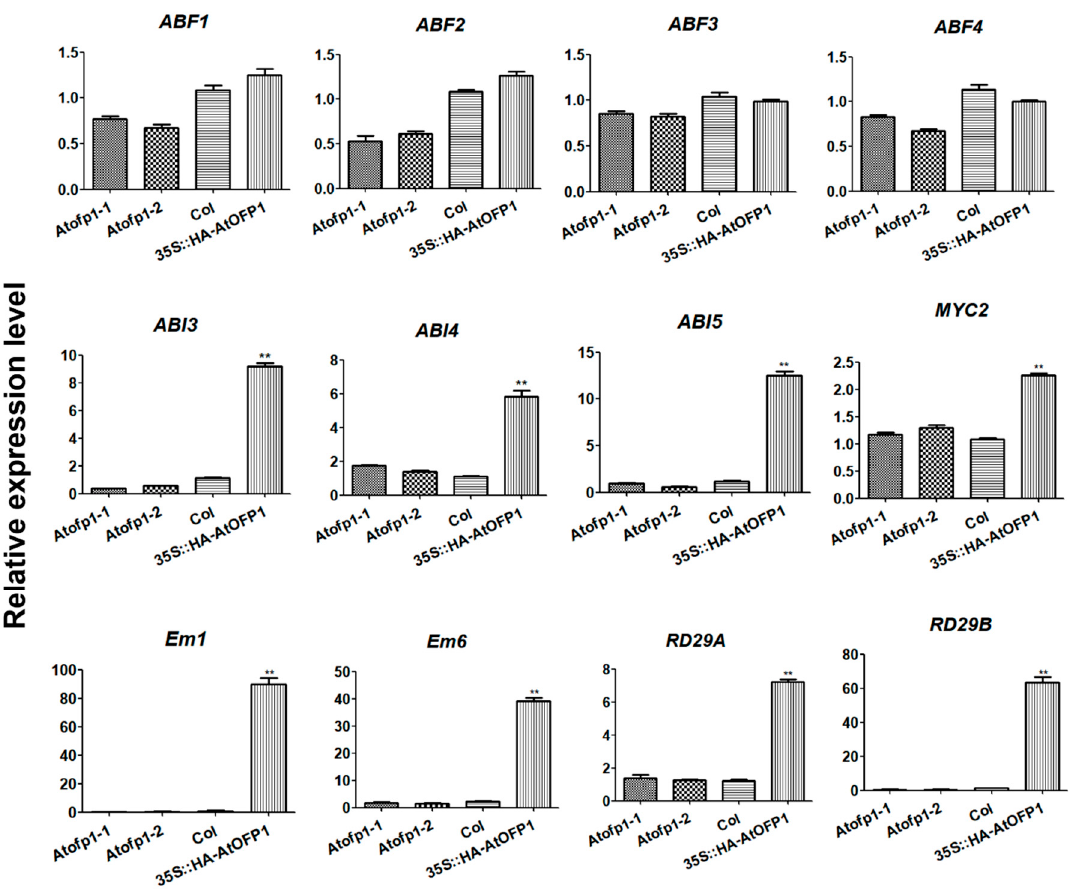
Figure 2. Expression levels of ABA-responsive genes. Note: qRT-PCR analysis of ABA-responsive genes in 10-day-old seedlings of Col, Atofp1-1 , Atofp1-2 and 35S::HA-AtOFP1 . Transcript levels of these genes were quantified relative to that of Actin2/8. Each data bar represents the means ± SE ( n = 3). Asterisk (**) indicates significantly statistical difference ( p < 0.01).